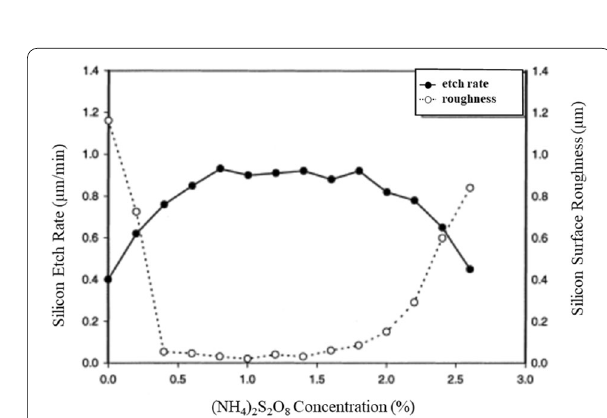
Fig. 25 Etch rate and surface roughness of Si{100} as a function of